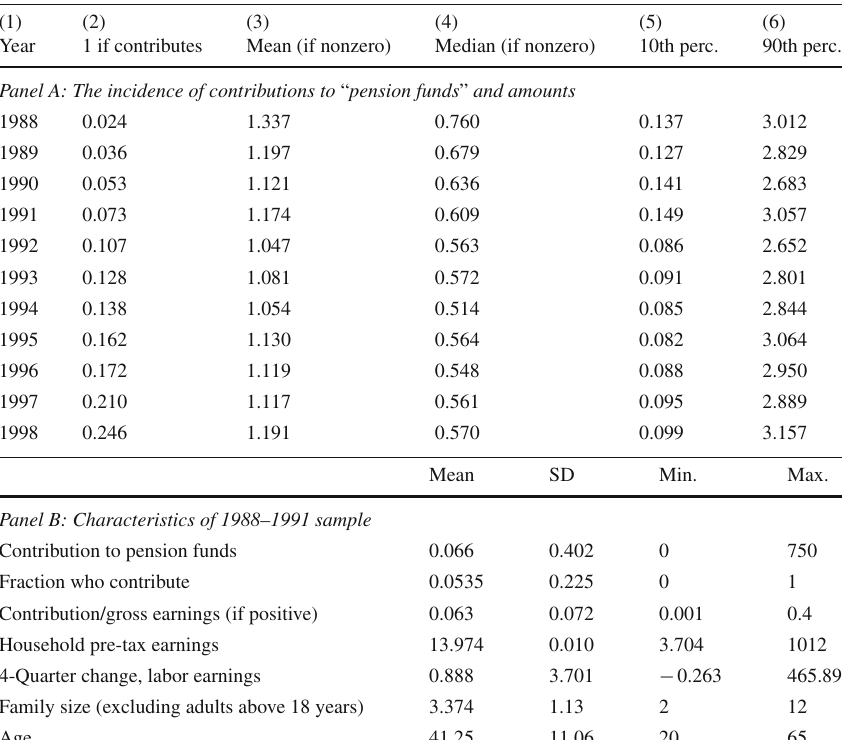
Table 1 Summary statistics of panel of tax